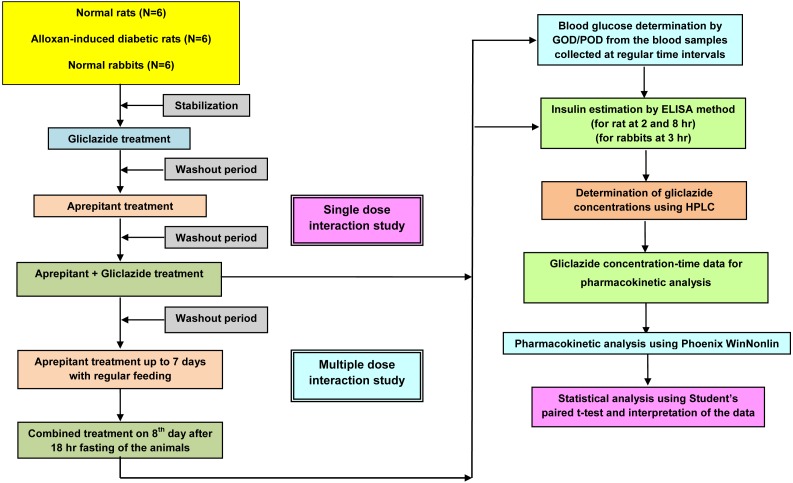
Experimental design.